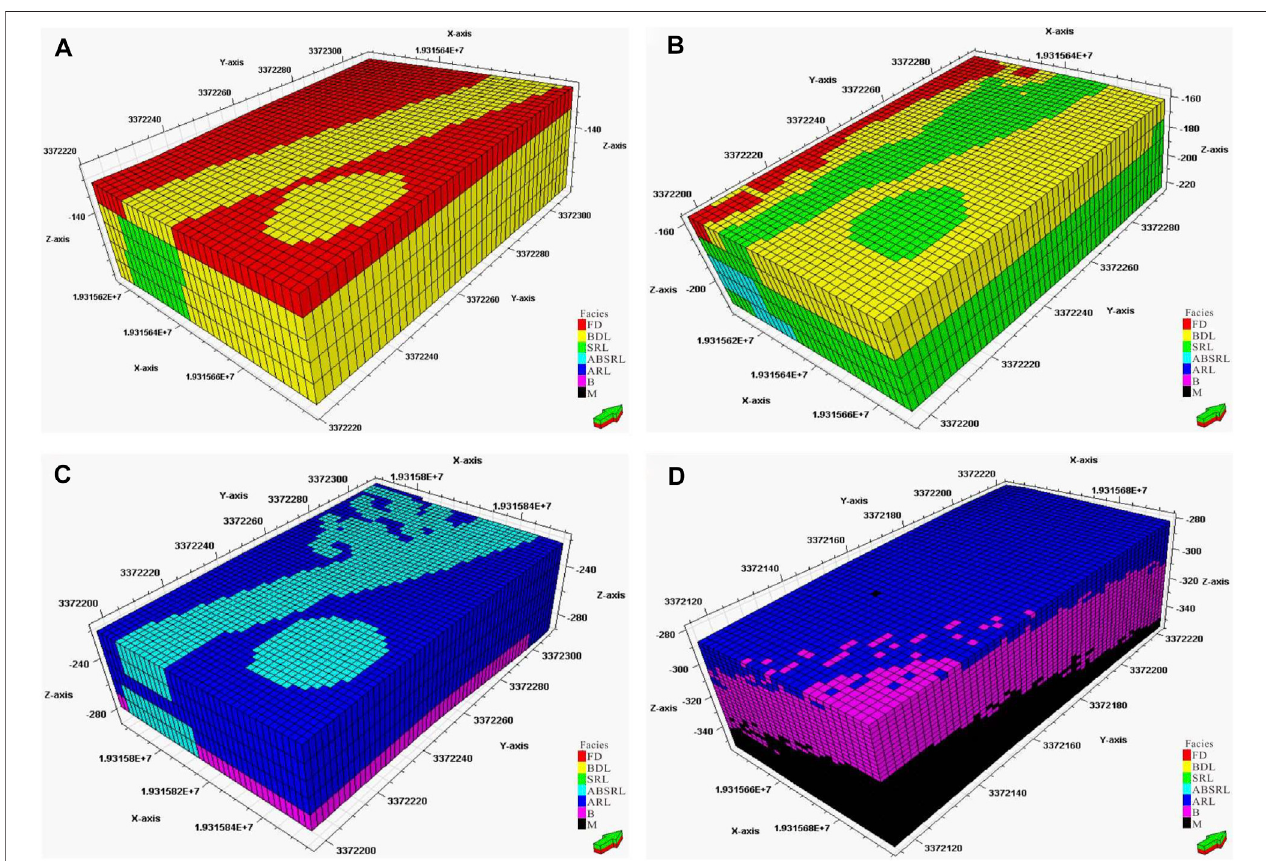
FIGURE 11 | 3-D training image model of each lithological microfacies. (A) Reef crest; (B) reef core; (C) bioherm; (D) reef base.